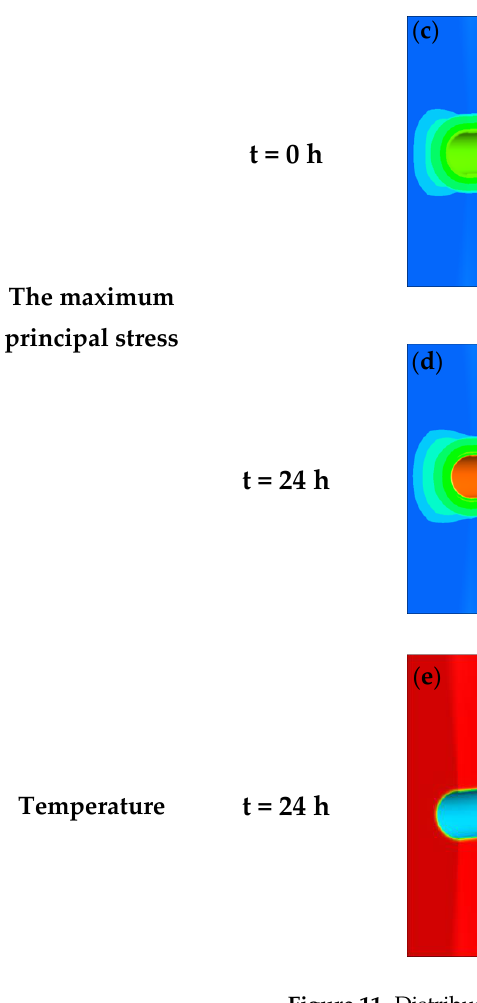
Figure 11. Distribution of temperature and the maximum and minimum principal stresses in tunnels with 5 and 10 m radii at different times. ( a ) Minimum principal stress in tunnel (R = 5 m) when t = 0 h (The value in the red frame is the maximum of the minimum principal stress (compressive)). ( a’ ) Minimum principal stress in tunnel (R = 10 m) when t = 0 h (The value in the red frame is the maximum of the minimum principal stress (compressive)). ( b ) Minimum principal stress in tunnel (R = 5 m) when t = 24 h. ( b’ ) Minimum principal stress in tunnel (R = 10 m) when t = 24 h. ( c ) Maximum principal stress in tunnel (R = 5 m) when t = 0 h. ( c’ ) Maximum principal stress in tunnel (R = 10 m) when t = 0 h. ( d ) Maximum principal stress in tunnel (R = 5 m) when t = 24 h (The value in the red frame is the maximum of the maximum principal stress (tensile)). ( d’ ) Maximum principal stress in tunnel (R = 10 m) when t = 24 h (The value in the red frame is the maximum of the maximum principal stress (tensile)). ( e ) Distribution of temperature in tunnel (R = 5 m) when t = 24 h. ( e’ ) Distribution of temperature in tunnel (R = 10 m) when t = 24 h.